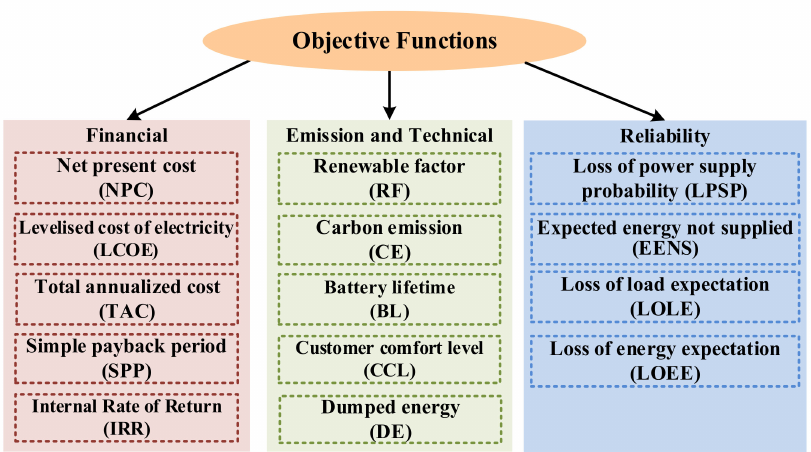
Figure 7. Objective functions for optimal planning of RAES systems.